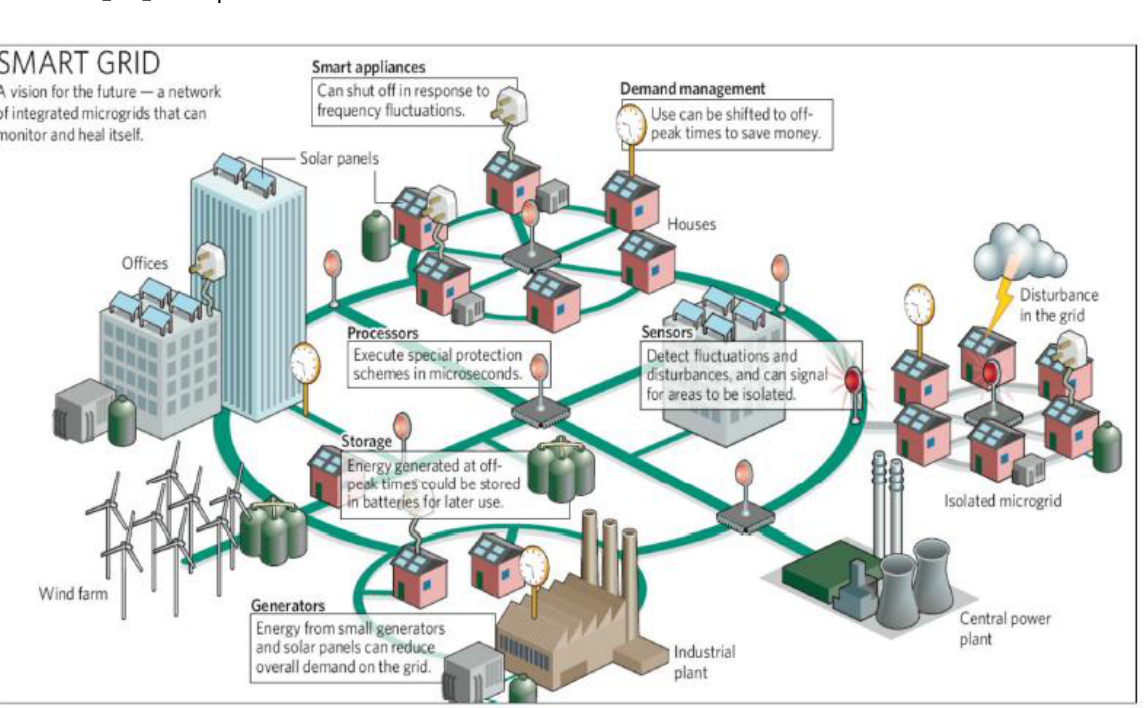
Figure 1. An illustration of an idealized vision of the “smart grid” future reproduced from Nature [27] with